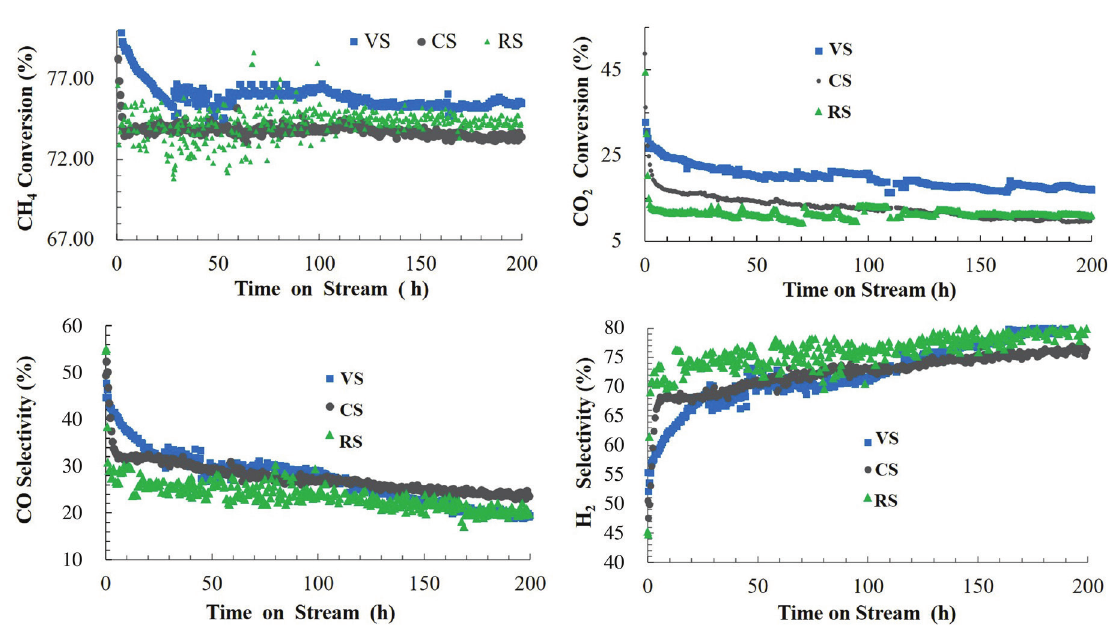
Fig. 7 – DMR performance of VS, CS, and RS packing patterns for DMR reactions at 600 °C, feed composition